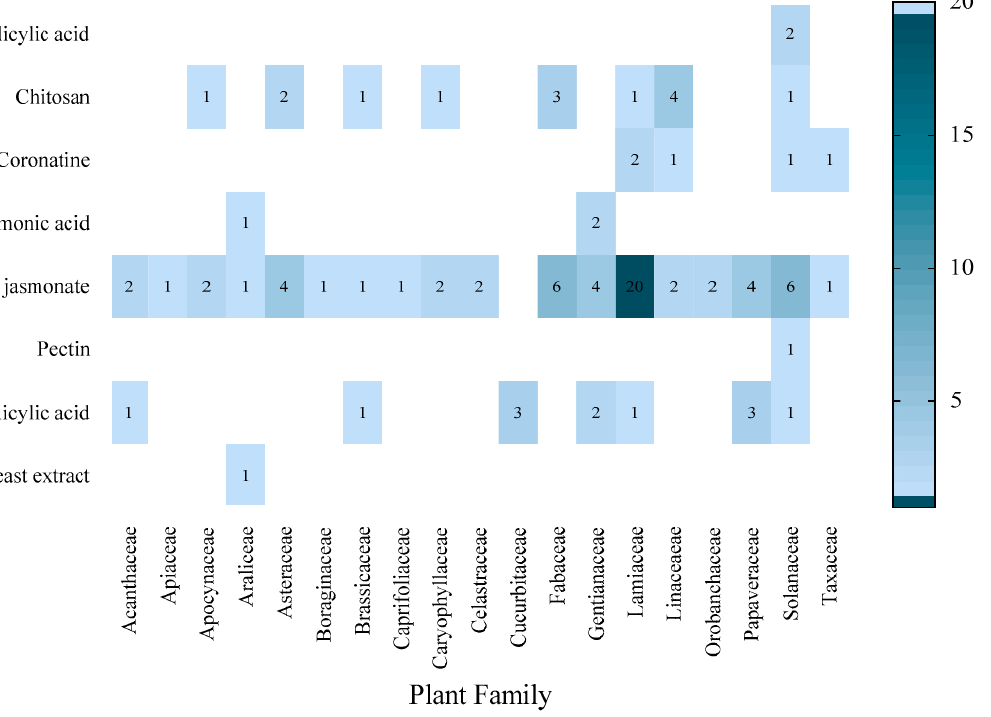
Figure 3. Number of records of each elicitor applied in hairy root cultures by plant family, from 2010 to 11 January to 11 January 2022.